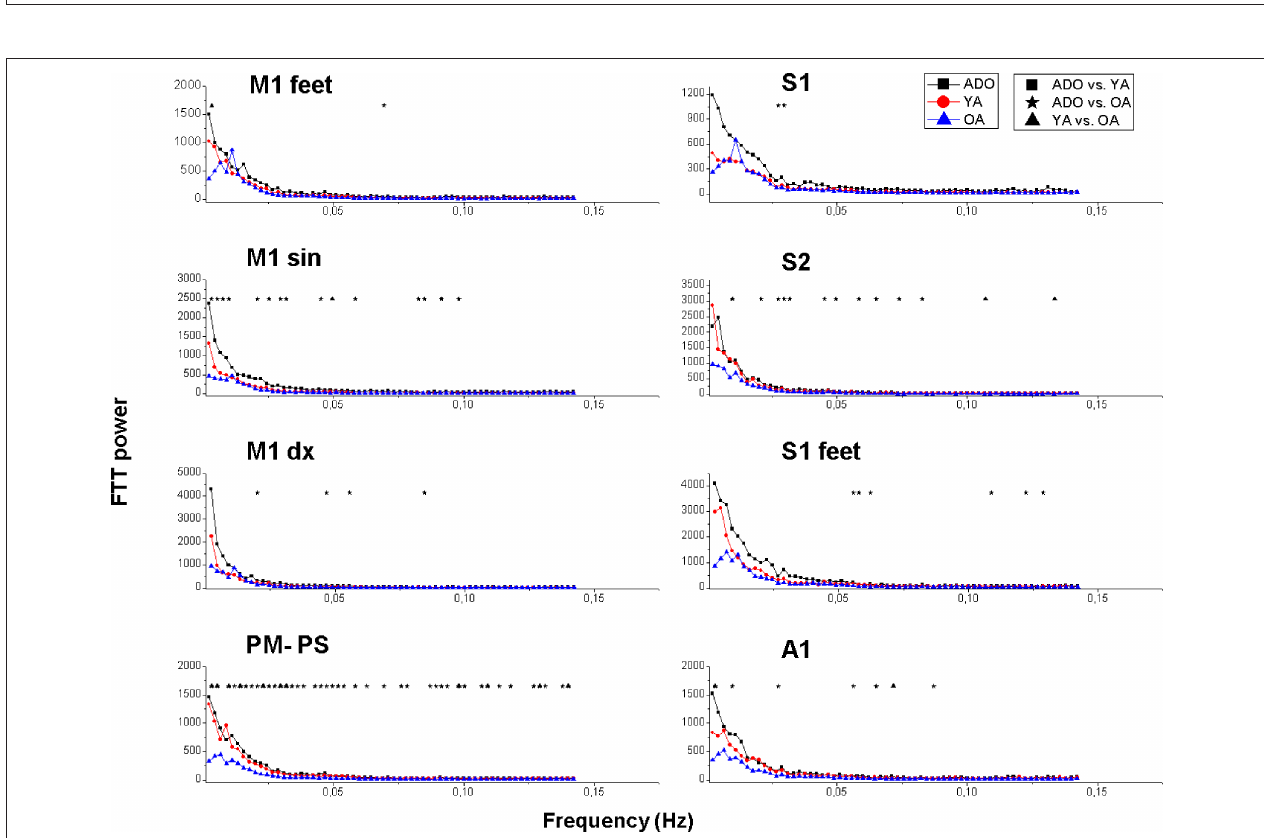
Figure 6 | Mean power spectra of in peri-rolandic signal sources presented in a similar way as the power spectral results in Figure 3. The signal sources are visualized in Figures 4 and 5 .